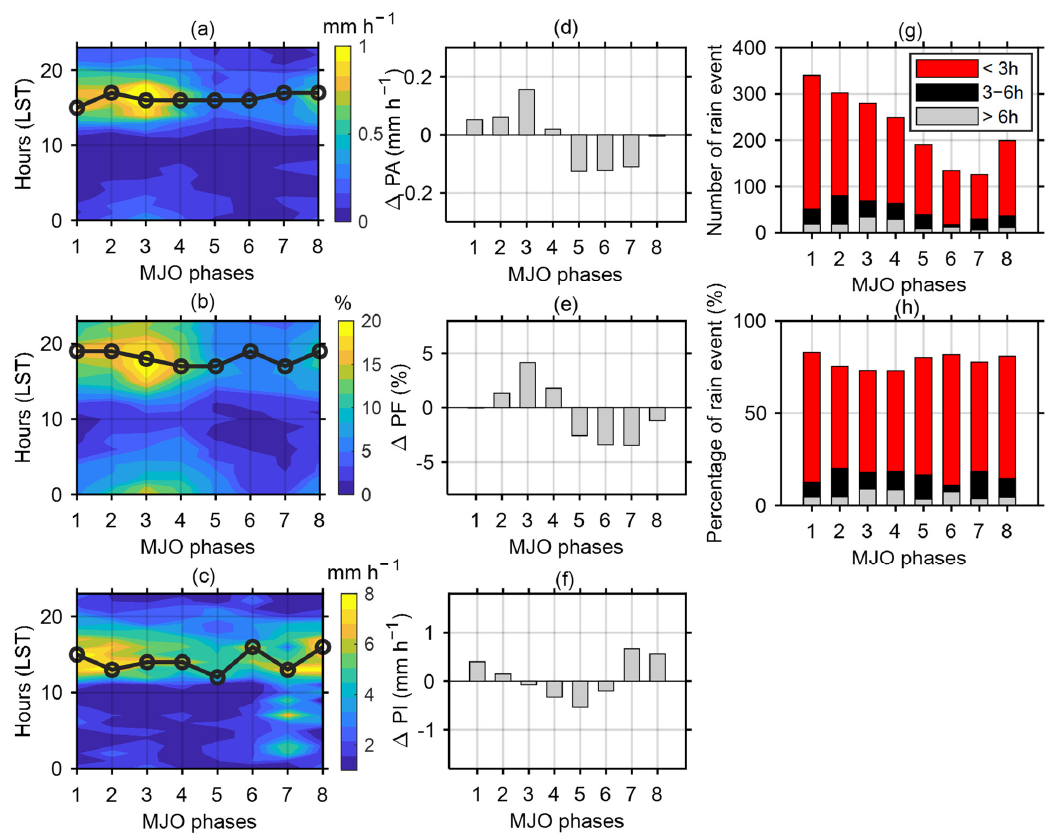
Figure 8. Intraseasonal variations in terms of MJO of the diurnal cycle of PA ( a ), PF ( b ), and PI ( c ), as well as their differences ( d−f ) with the average climatological values described in Section 3.1, along with the number ( g ) and percentage ( h ) of rain events for different rain event durations. Lines with circle markers indicate the peak time of PA ( a ), PF ( b ), and PI ( c ). The percentage shown in Figure 8h is calculated by dividing the number of events for each duration by the total number of events in that MJO phase.